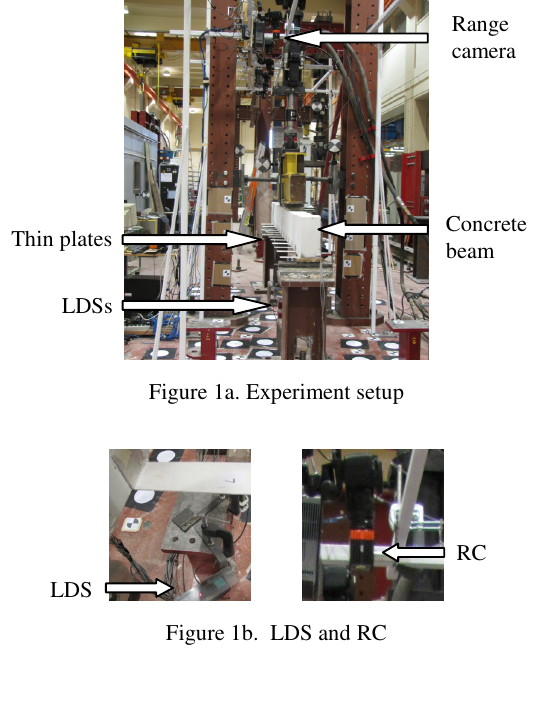
Figure 1b. LDS and